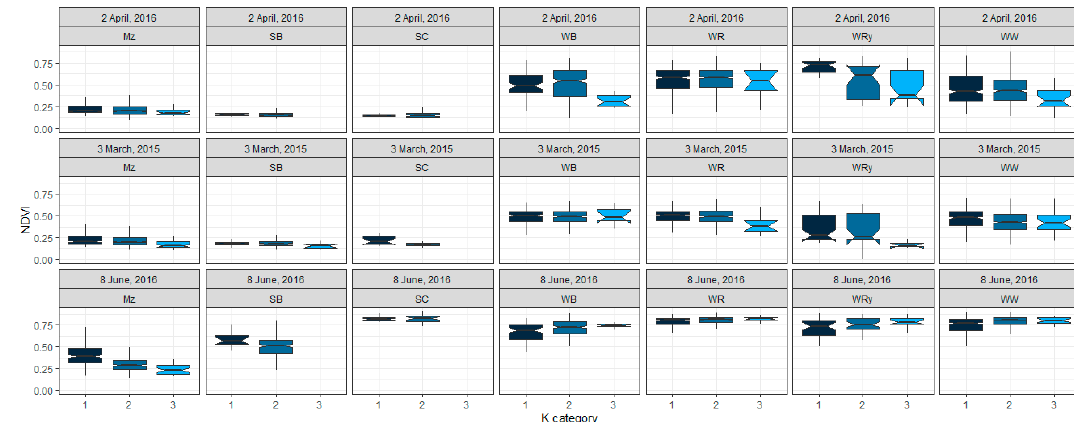
Figure 7. Comparison of surface reflectance (SR) values across soil erodibility (K) categories in different images (scene dates chosen based on statistically significant impact on C ndvi according to Table 4). K categories: 1, ≤ 0.15; 2, = 0.15 to 0.3; 3, ≥ 0.3. The notches in the boxes indicate statistical significance in median reflectance of Red and Near Infrared (NIR) along the K categories at a 95% confidence interval.